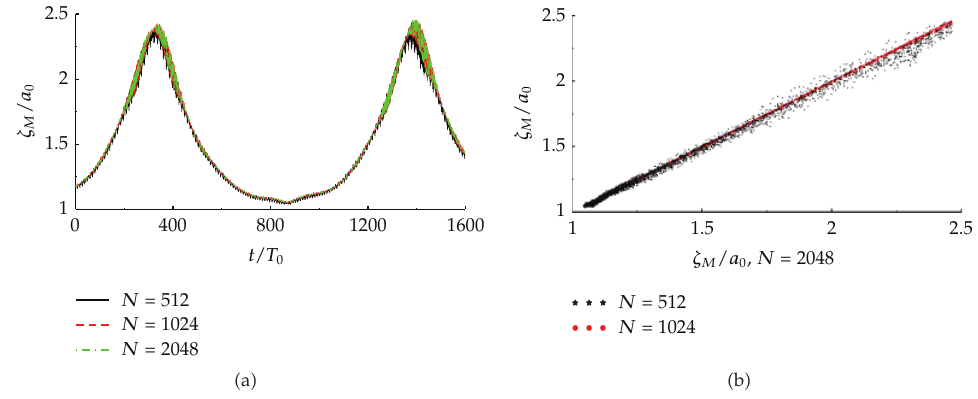
Figure 6: The maximum wave crest histories (cid:2) a (cid:3) and scatter diagram (cid:2) b (cid:3) of Stokes-modulated wave train for ε 0 (cid:7) 0 . 05, r 1 (cid:7) 0 . 1, M (cid:7) 4, T 0 / Δ t (cid:7) 64 with di ff erent N.